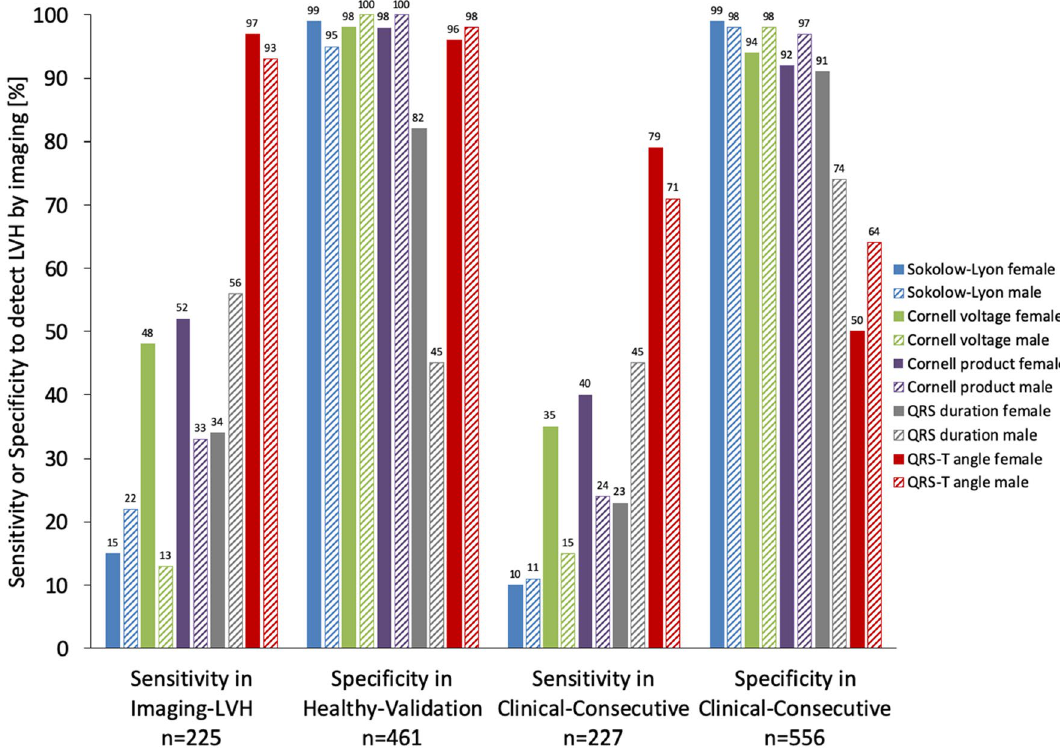
Figure 3. Sex-specific sensitivity or specificity for detecting anatomically defined left ventricular hypertrophy (LVH) in the respective cohorts. In both the Imaging-LVH and Clinical-Consecutive cohorts, an increased QRS-T angle had a higher sensitivity for LVH than all other ECG measures ( p < 0.05 for all). Among females in the Healthy-Validation cohort, the specificity of the QRS-T angle for LVH was higher than that of QRS duration ( p < 0.001), lower than Cornell product ( p < 0.05), and did not differ significantly from that of the other measures ( p > 0.05 for all). Among males in the Healthy-Validation cohort, the specificity of the QRS-T angle for LVH was higher than that of QRS duration ( p < 0.001), lower than Cornell voltage and Cornell voltage product ( p < 0.05 for both), and did not differ significantly from Sokolow-Lyon index ( p = 0.12). In the Clinical-Consecutive cohort, the QRS-T angle had a lower specificity than the other ECG measures ( p < 0.05 for all) despite its excellent specificity in the Healthy-Validation cohort, suggesting possible electrical identification of subclinical disease in patients who do not yet fulfill imaging criteria for